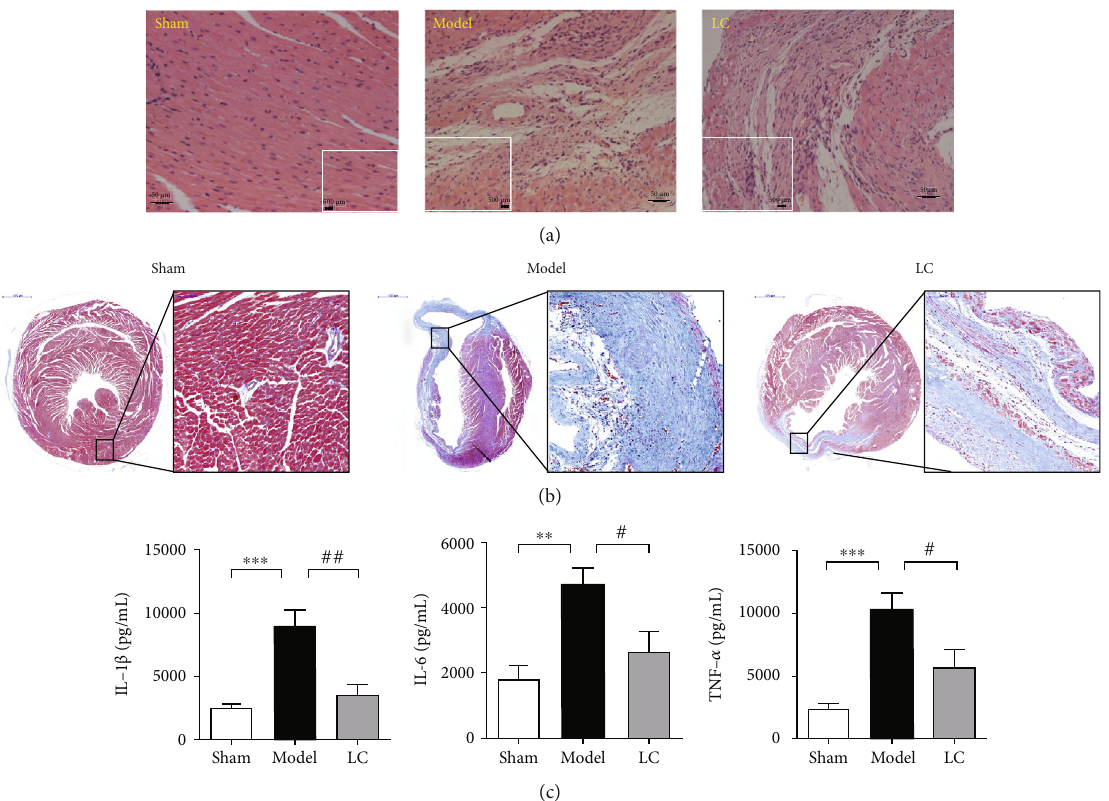
Figure 3: LC suppressed the levels of proin fl ammatory cytokines and ameliorated cardiac hypertrophy and fi brosis of post-MI mice. (a) Representative image of H&E staining, scalebar = 500 μ m in original images and scalebar = 50 μ m in enlarged plots. (b) Masson ’ s trichrome-stained heart para ffi n sections: collagen was stained in blue and cytoplasm was stained in red, scalebar = 1000 μ m in original images and scale bar = 100 μ m in enlarged plots. (c) Levels of proin fl ammatory cytokines were measured after LC treatment. Data were expressed as means ± SEM . n = 5 ; ∗∗ p < 0 : 01 , ∗∗∗ p < 0 : 001 , compared to the sham group. # p < 0 : 05 , ## p < 0 : 01 , compared to the model